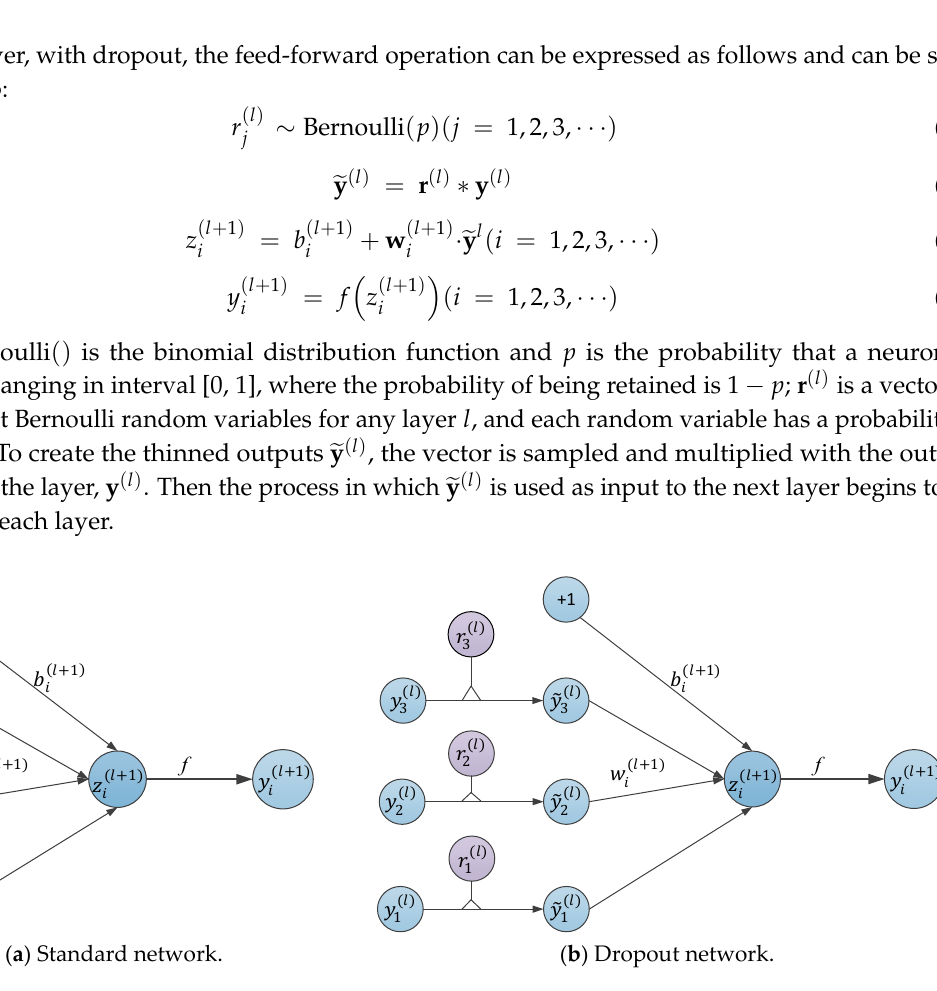
Figure 5. A comparison of the basic operations between the standard and dropout networks.